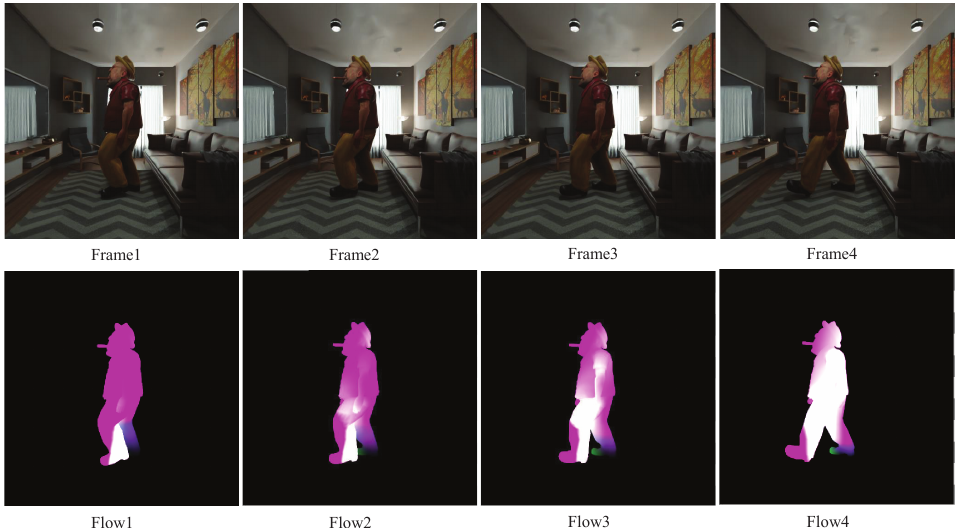
Figure 5. Rendered images and corresponding